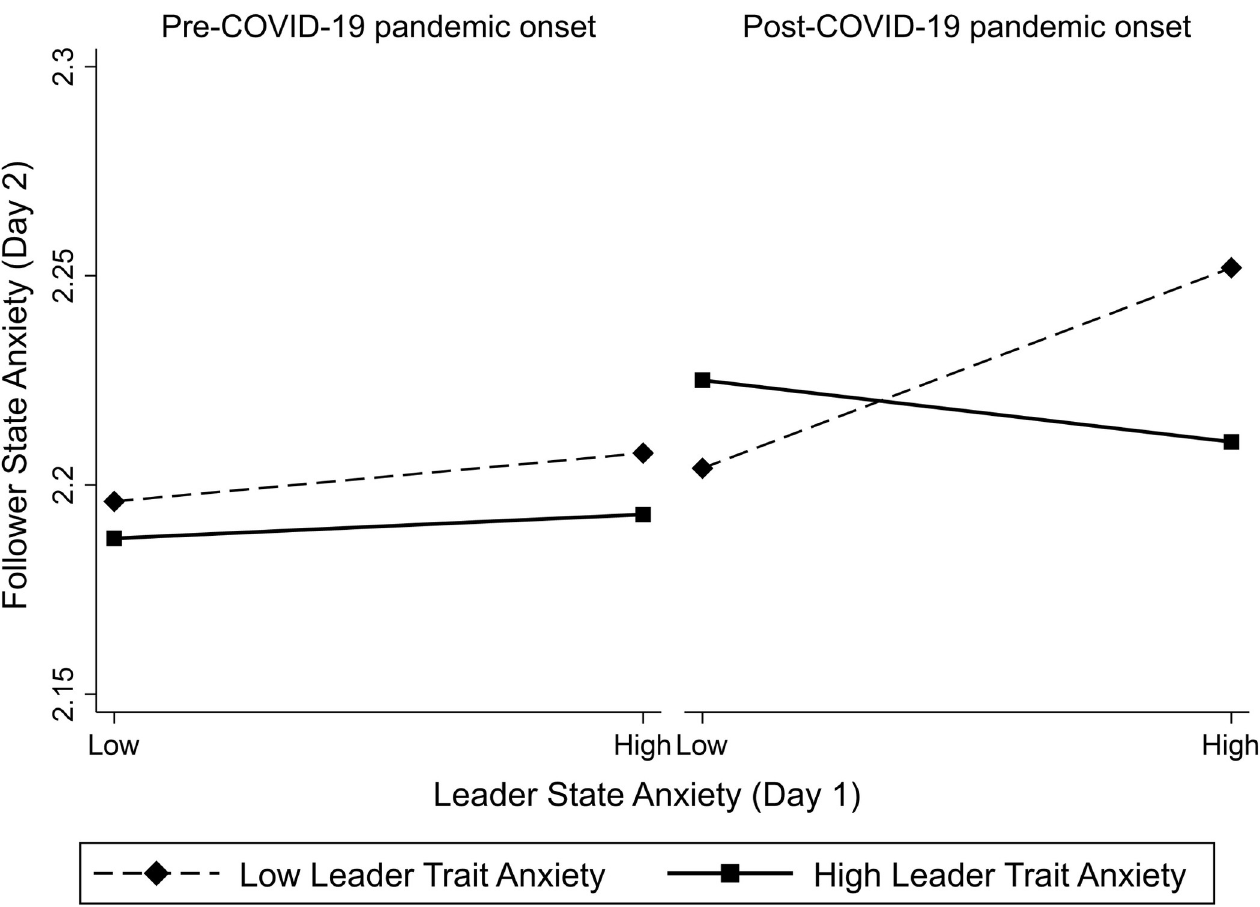
Fig 1. Regression interaction between leader state- and leader trait anxiety on follower state